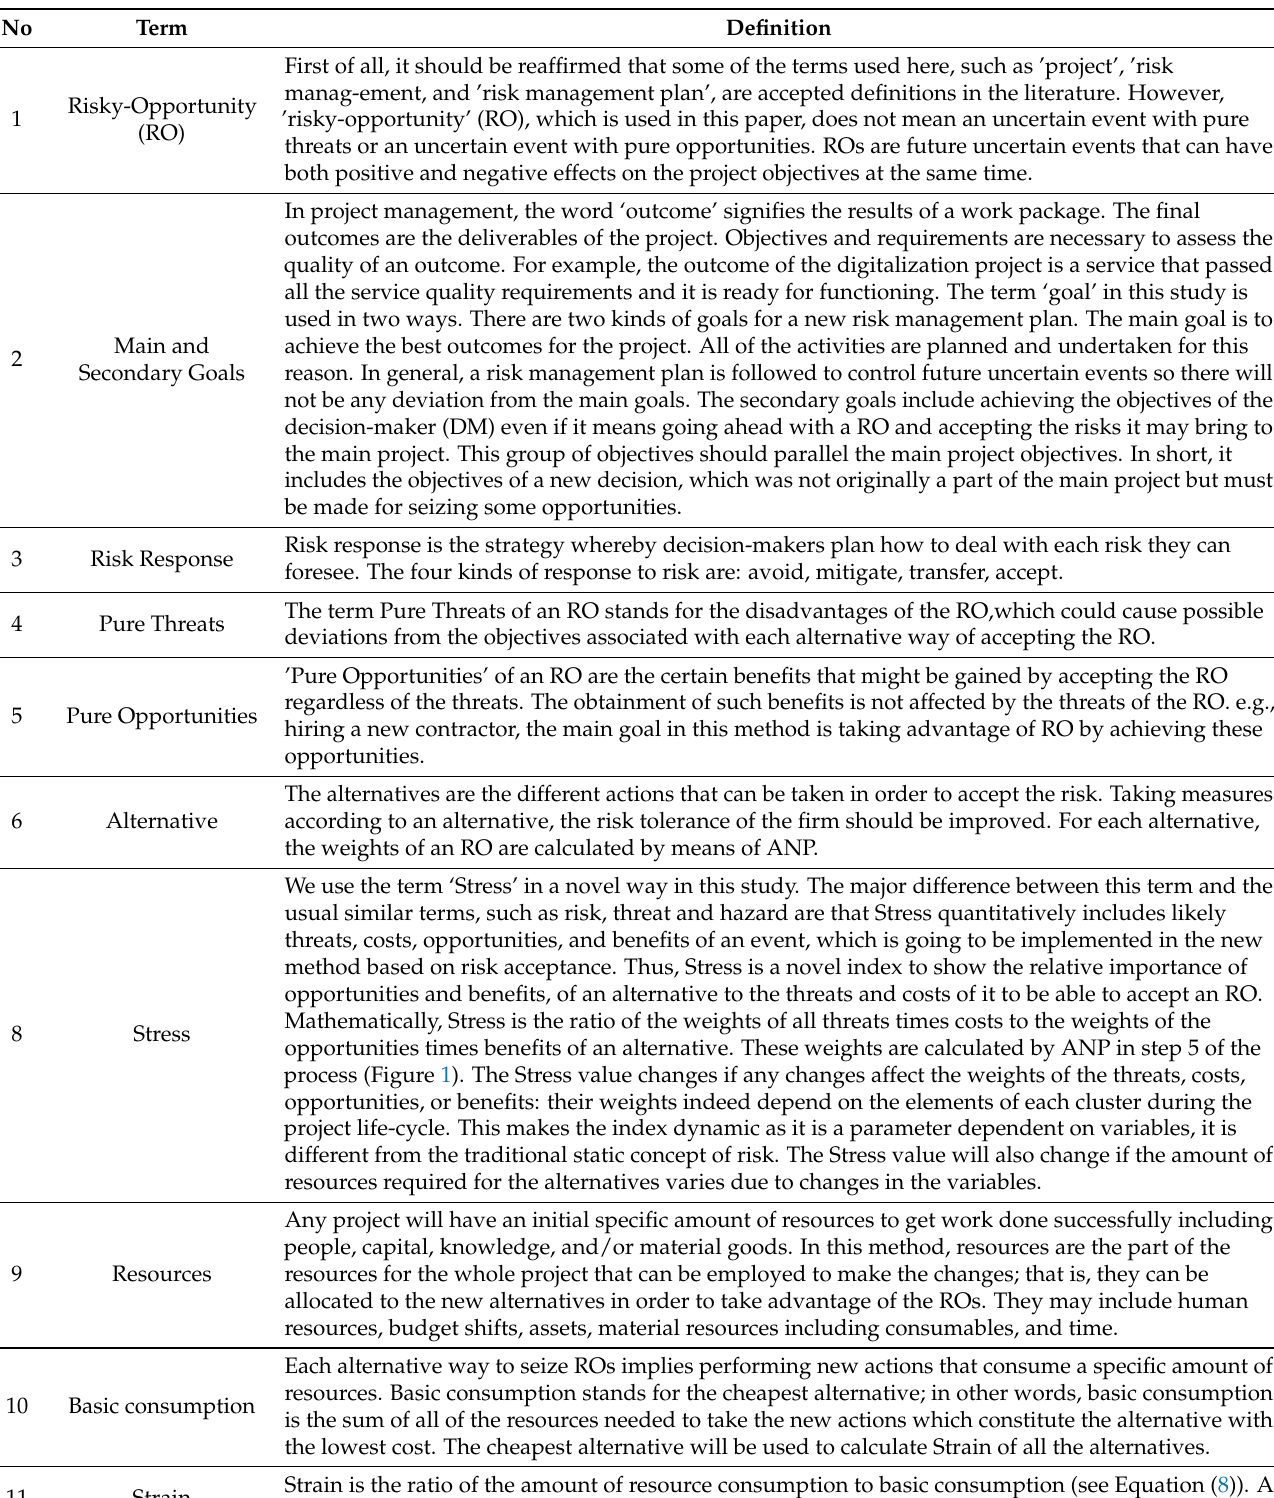
Table 1. Terminology and